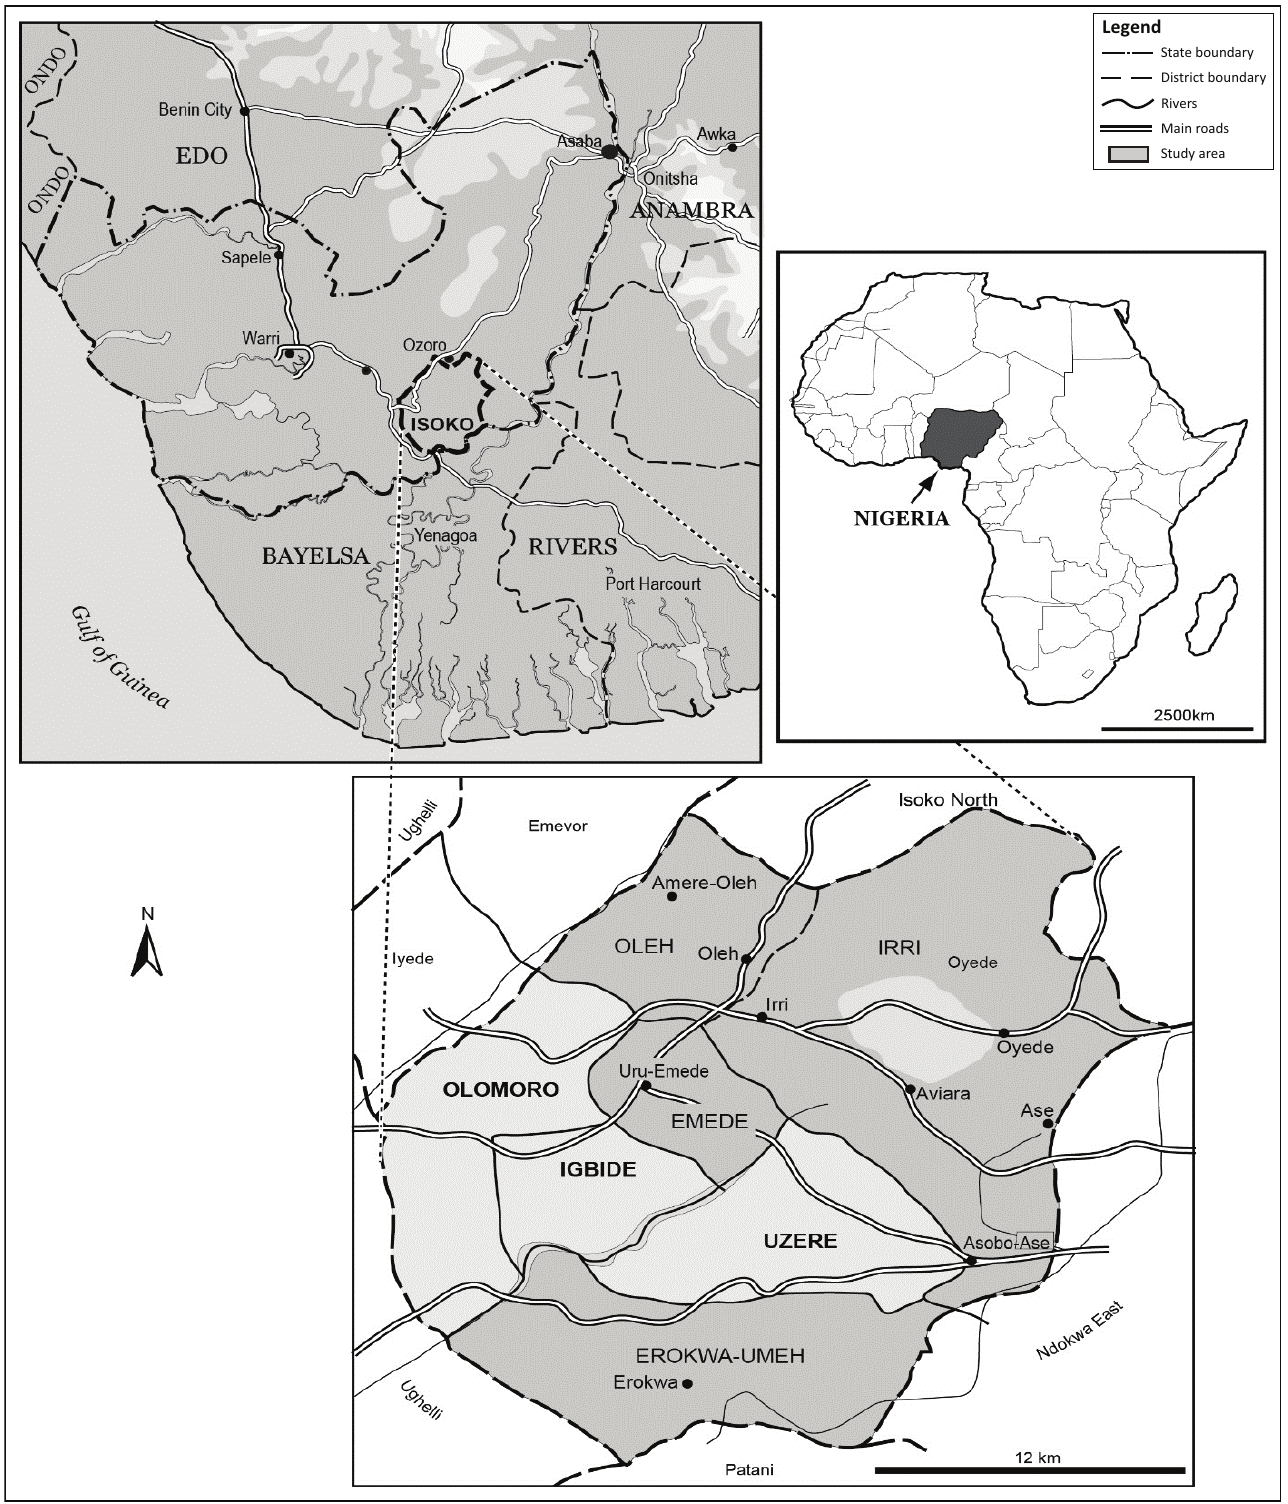
FIGURE 1: Map of the study areas in the Delta State, Nigeria. seasonal inundation of their low-lying farmlands, they are constrained to cultivate for approximately 8 months